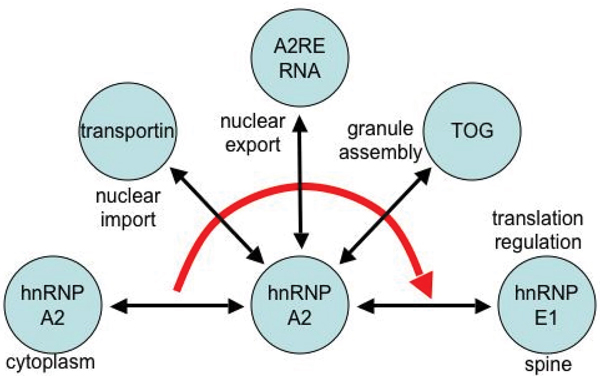
Molecular interactions of hnRNP A2 in the A2 RNA trafficking pathway. Five different molecular partners of hnRNP A2 have been identified in the A2 RNA trafficking pathway – hnRNP A2 itself, transportin 1, A2RE RNA, TOG and hnRNP E1. Each step of the A2 RNA trafficking pathway is mediated by interaction of hnRNP A2 with a particular partner. Although interactions between hnRNP A2 and each partner are reversible, the overall pathway exhibits polarity.